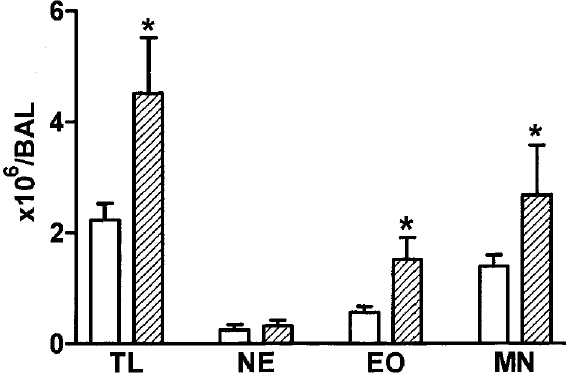
FIG. 1. Effects of mild chronic prenatal stress on total and differential (neutrophils, eosinophils and mononuclear cells) leukocyte counts in bronchoalveolar lavage (BAL) fluid from actively sensitized female offspring after 48h following intratracheal injection of ovalbumin (OVA). Open columns represent non-stressed, whereas hatched columns represent prenatally stressed offspring. Each column represents the mean±S.E.M. ( n =11–15). * P <0.05 compared to their respective controls. TL, total leukocytes; NE, neutrophil; MN, mononuclear cell; EO, eosinophil.